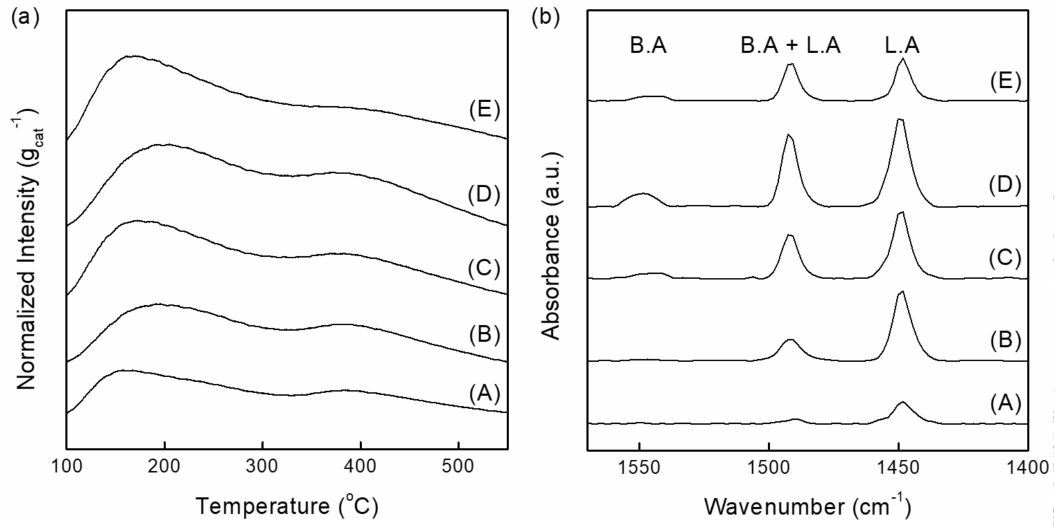
Figure 5. ( a ) NH 3 -TPD profiles and ( b ) py -FT-IR spectra of (A) NiOx / SA-001, (B) NiOx / SA-007, (C) NiOx / SA-028, (D) NiOx / SA-047, and (E) NiOx / SA-386. Table 4. Acid site properties determined by NH 3 -TPD and pyridine-FT-IR ( py